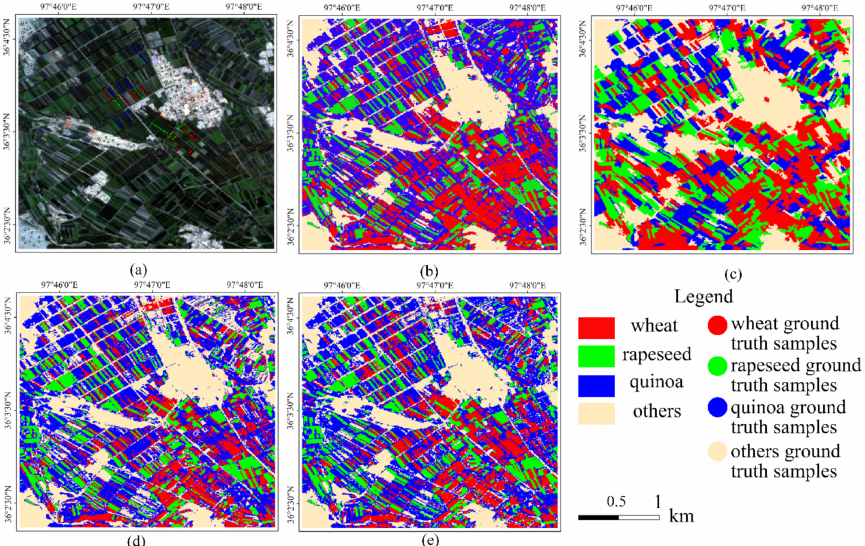
Figure 11. Result diagram of different methods classification. ( a ) Study area true color image (Red, Green, Blue) display; ( b ) Classification results of random forest classification method; ( c ) Classification results of object-oriented classification method; ( d ) Classification results of deep neural network classification method; and ( e ) Classification results of RF+DNN classification